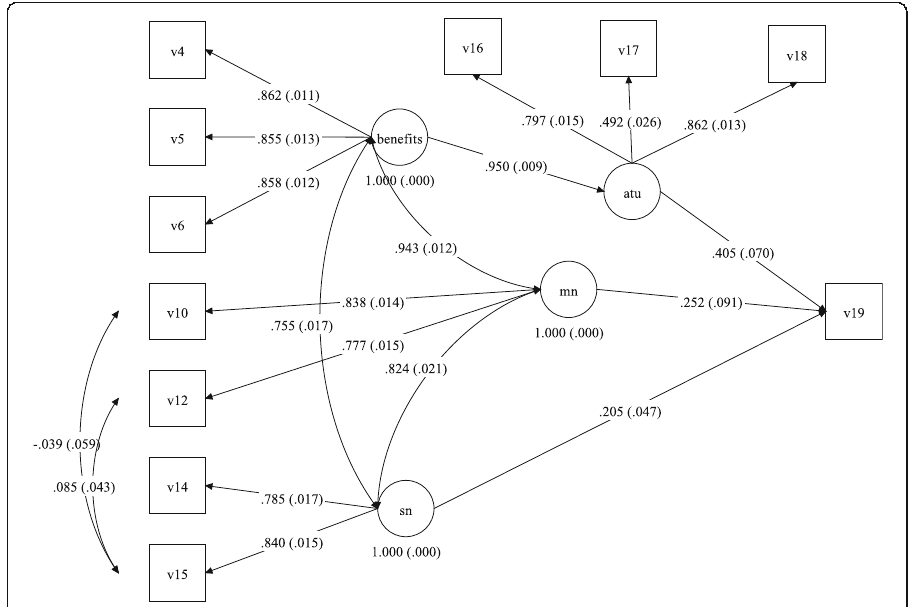
Fig. 10 Final pooled model for ‘ prolonged maternal feeding ’ . Standardised parameter estimates are shown with associated standard errors in